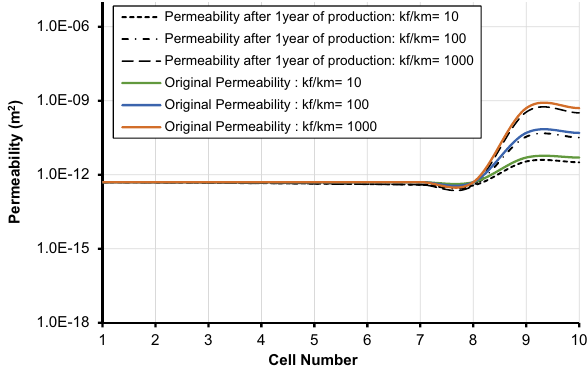
Fig. 7 Effect of fracture-to-matrix permeability ( k